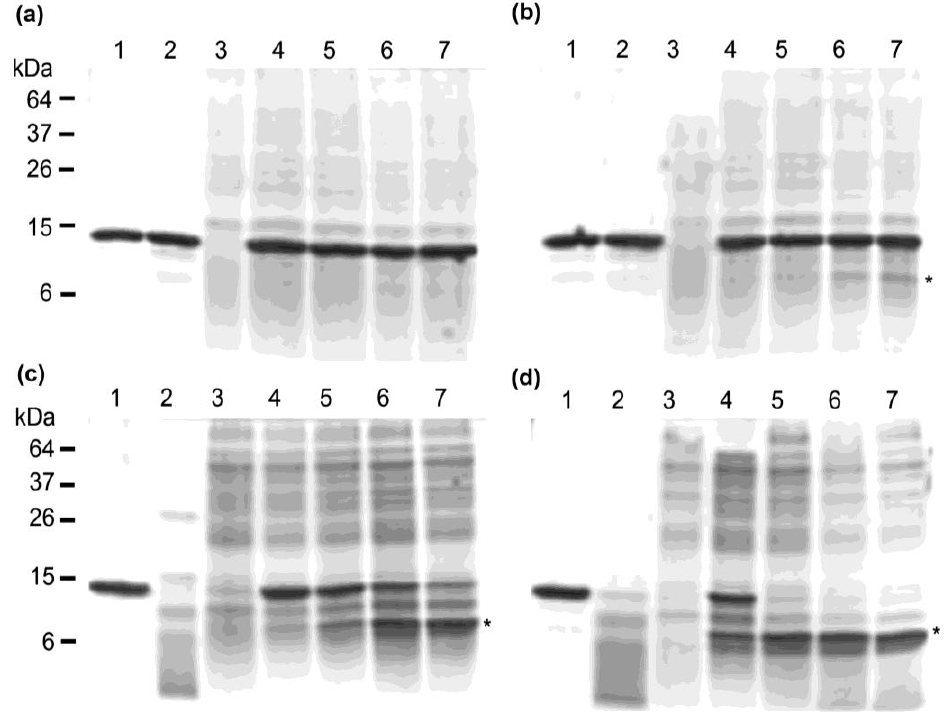
Figure 5. SDS-PAGE analysis of V s during incubation with murine stomach and NAR intestinal scrapings. ( a ) Incubation at 4 °C, Lane 1 : untreated 14M-15, Lane 2 : 14M-15 with pH 3 glycine, Lane 3 : Murine stomach sample, Lane 4 : Murine stomach sample with 14M-15, 1 min incubation, Lane 5 : Murine stomach sample with 14M-15, 10 min incubation, Lane 6 : Murine stomach sample with 14M-15, 30 min incubation, Lane 7 : Murine stomach sample with 14M-15, 60 min incubation. ( b ) Incubation at 37 °C, loading same as ( a ). ( c ) Incubation at 4 °C, Lane 1 : untreated 14M-15, Lane 2 : 14M-15 with proteinase K, Lane 3 : Murine intestinal sample, Lane 4 : Murine intestinal sample with 14M-15, 1 min incubation, Lane 5 : Murine intestinal sample with 14M-15, 10 min incubation, Lane 6 : Murine intestinal sample with 14M-15, 30 min incubation, Lane 7 : Murine intestinal sample with 14M-15, 60 min incubation. ( d ) Incubation at 37 °C, loading same as ( c ). *14M-15 degradation products resulting from acid or protease